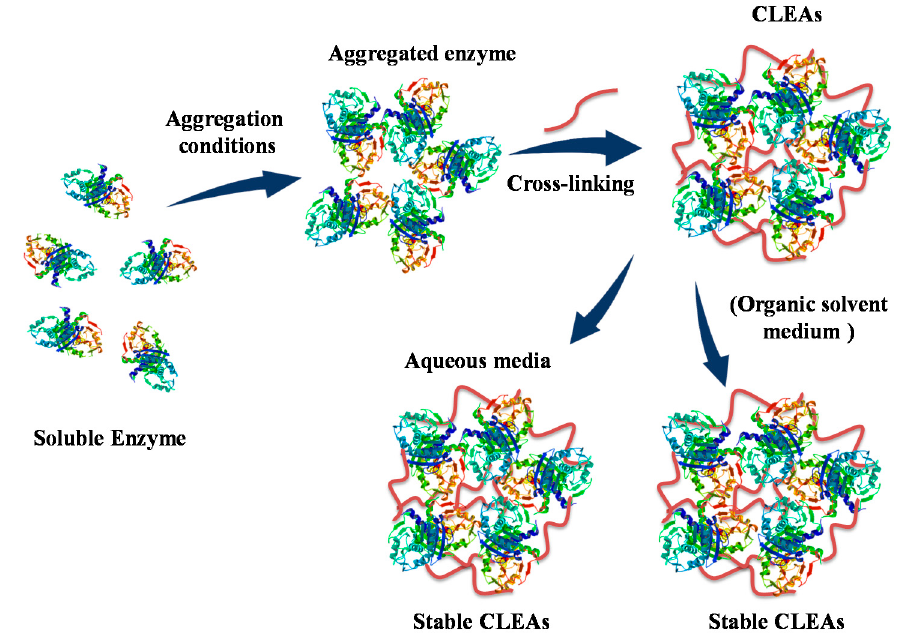
Figure 5. Schematic representation of enzyme immobilization via cross-linked enzyme aggregates technique (CLEAs).